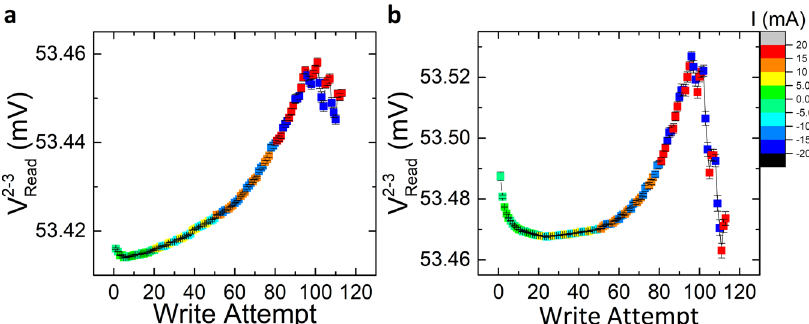
Fig. 6 180° switching in IrMn 3 /Pt pillar, measured as a function of the write current amplitude. The color map corresponds to the amplitude and direction of the writing current applied before the differential voltage measurement. The graphs correspond to cases a when the current pulse is applied between electrodes 2 and 6, I 2-6 write , and b when the writing current is applied between electrodes 1 and 4, I 1-4 write . For both cases, the device resistance increases due to Joule heating as we apply more write attempts, and for current pulses above 18 mA the output voltage shows a switching behavior, indicating a threshold current density of ~36 MA/cm 2 for switching in this structure. Each data point corresponds to the mean value of 170 consecutive measurements and the error bar to the standard